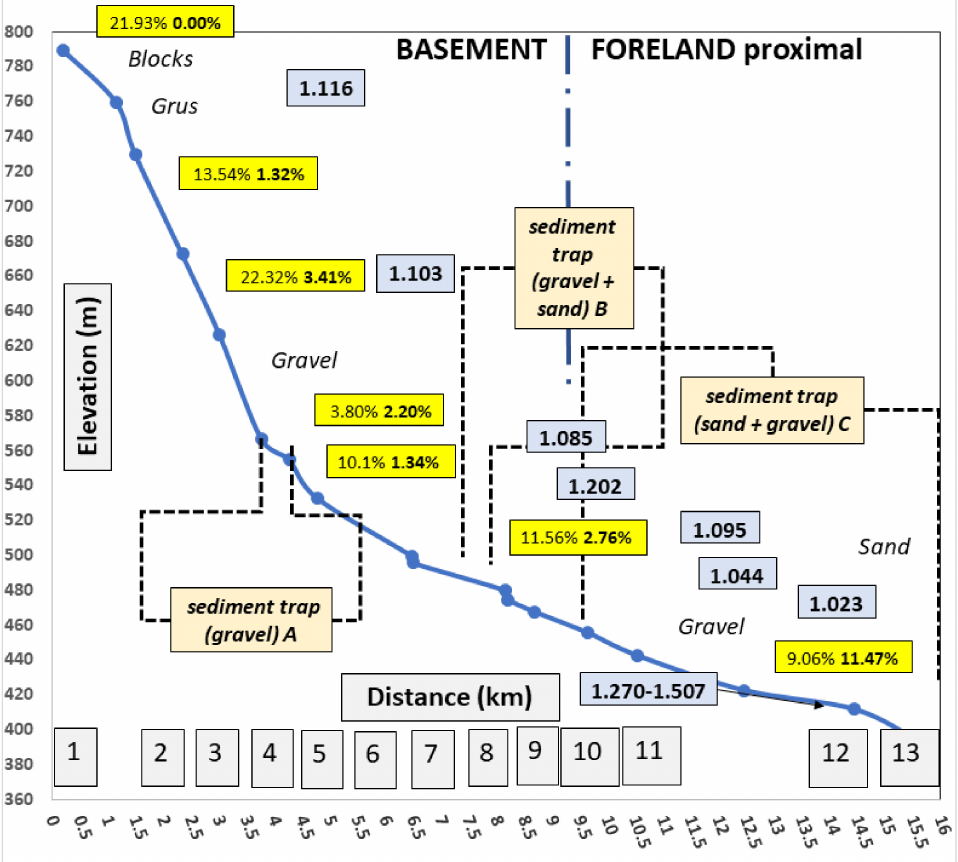
Figure 5. Longitudinal profile from the headwaters in the basement to the depositional area in the foreland showing the quantity of mass wasting and fluvial sediments. Blue boxes: degree of sinuosity (for calculation see text); beige boxes: intermediate sediment traps with prevailing grain size categories (A, B, and C refer to localities mentioned in the text); yellow boxes: normal types = areal distribution of mass wasting deposits per km 2 /along the valley section, bold types = fluvial deposits per km 2 /along the valley section. The x-axis denotes in the line drawing the distance to the source area in kilometers and the sampling sites given in geological index map of Figure 3. The y-axis gives the elevation in meters above mean sea level. Modified